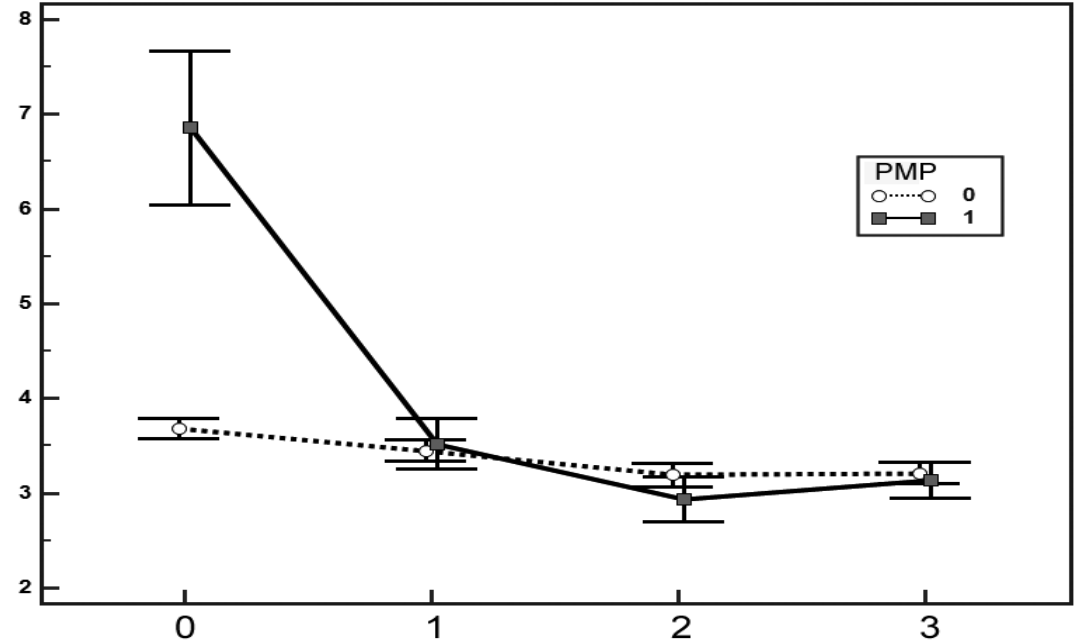
Figure 4. Longitudinal trends of the mean ± standard error for eNAMPT levels (ng/mL). Solid line: eNAMPT levels in patients with polyps with prominent malignant potential (PMP); dashed line: eNAMPT levels in patients with polyps lacking PMP. Time points: 0: baseline; 1: 24 weeks postpolypectomy; 2: 48 weeks postpolypectomy; 3: 96 weeks postpolypectomy.